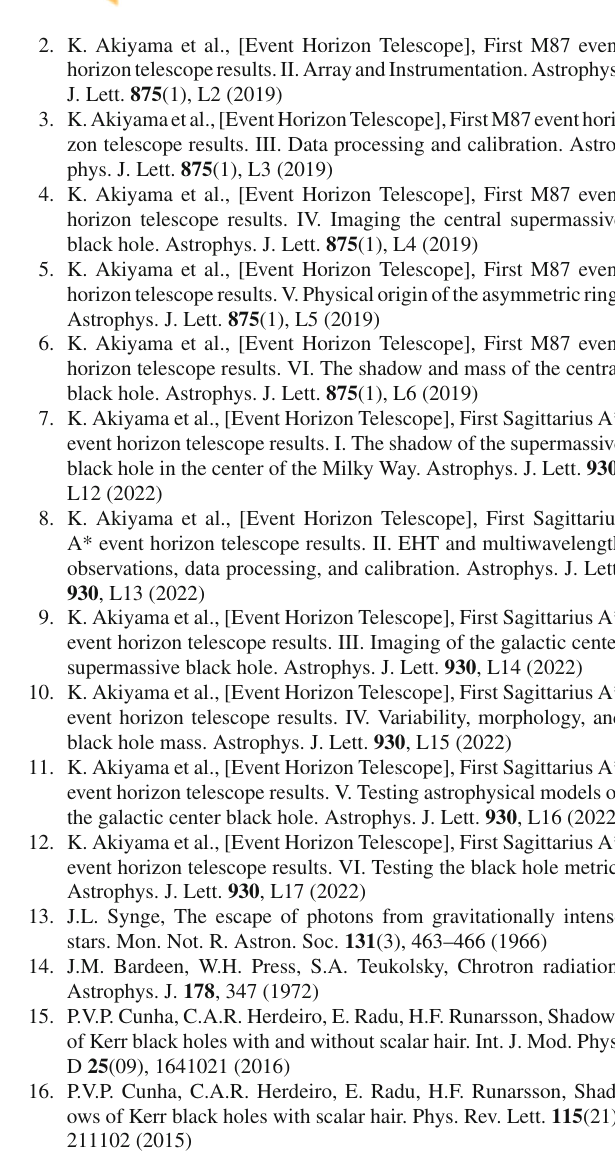
Fig. 8 The vector (cid:10) P is the photon’s 3-momentum in the observer’s frame, and (α,β) are the positive observation angles. The planes associated with the angles α and β are perpendicular to each other, and (cid:10) P is in the same plane as α . The vectors ˆ e (φ) and ˆ e ( r ) are also co-planar with